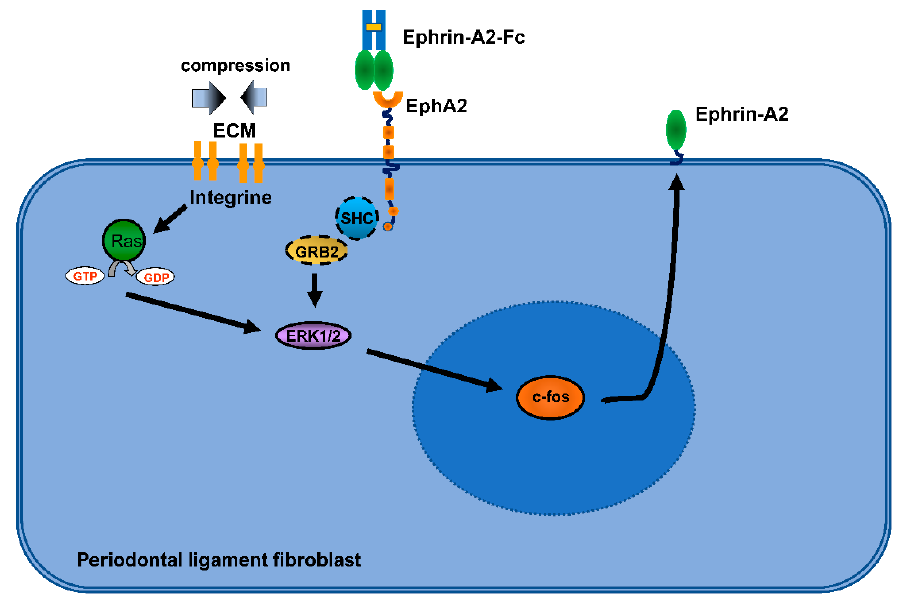
Figure 1. Putative signaling pathways involved in the regulation of ephrin-A2 in periodontal ligament fibroblasts (PDLFs). Both compression and stimulation by exogenous Ephrin-A2 induced ephrin-A2 expression via a signaling pathway involving GTPase Ras, ERK1/2 kinases and c-fos (ECM: extracellular matrix, SHC: Src homology 2 domain-containing adapter protein, GRB2: Growth factor receptor-bound protein 2).